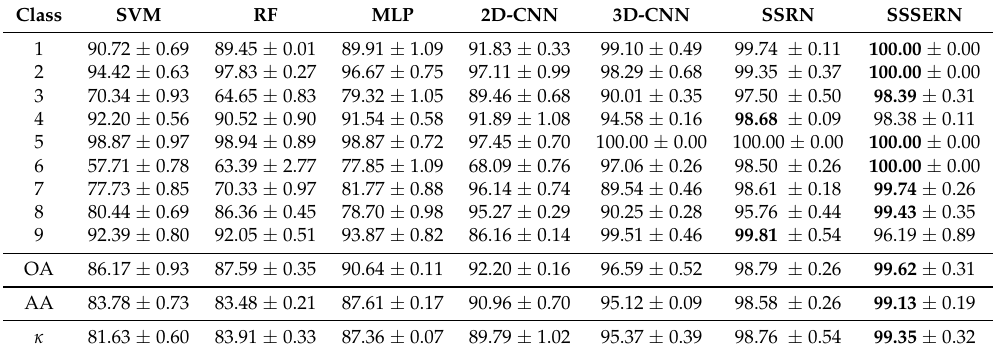
Table 5. Overall, average, and individual class accuracies and κ statistics in the form of mean ± standard deviation for the University of Pavia data set. The best results are highlighted in bold